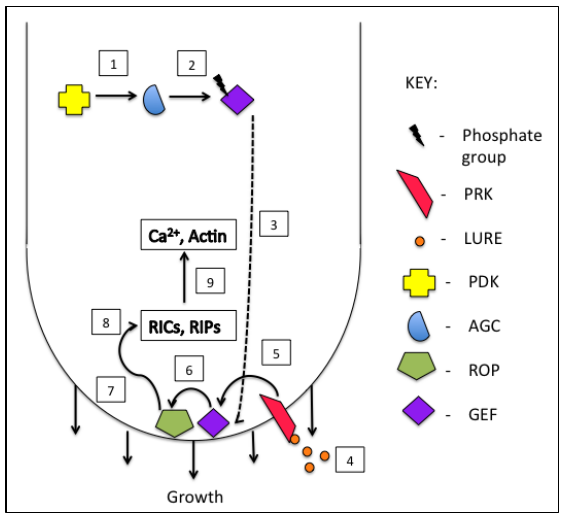
Figure 2. Overview of positive regulation of Rho GTPase (ROP). 3-phosphoinositide-dependent protein kinase (PDK) phosphorylates AGC kinase to regulate activity (1) which then goes on to phosphorylate Rho Guanine Exchange Factor (GEF) (2) affecting its localization to the membrane of the tube apex (3). Cysteine-rich polypeptide (LURE) molecules secreted from the transmitting tract stimulate activity of membrane localized pollen receptor-like kinase (PRK) (4), which activates GEF (5). GEF catalyzes the exchange of guanosine diphosphate (GDP) for guanosine triphosphate (GTP) and biological activation of ROP (6), which then activates downstream effectors such as ROP